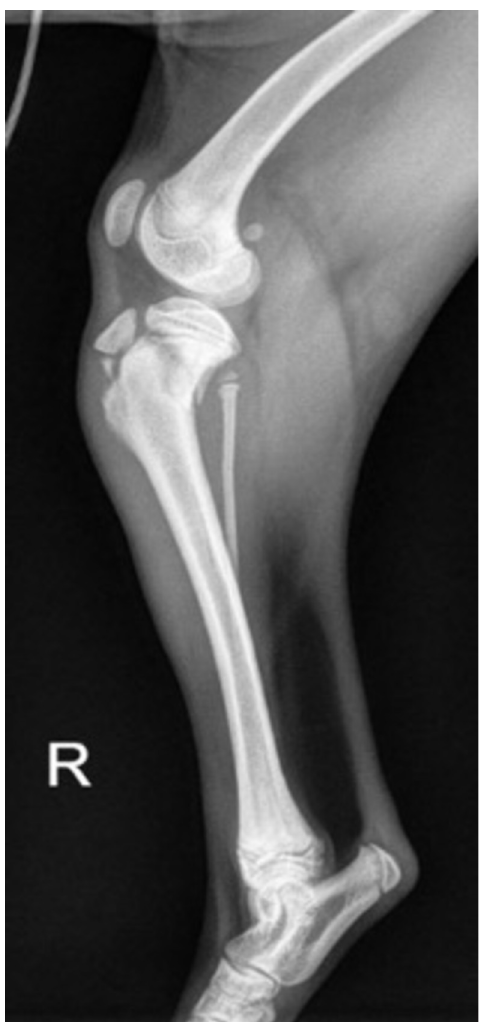
Fig 2. Mediolateral radiograph of a PTMF demonstrating cranial displacement of the distal fragment and caudal tipping of the proximal tibia resulting in an increased tibial plateau angle.